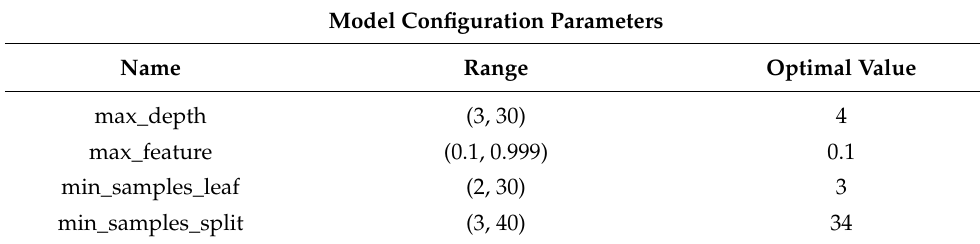
Table 2. Optimal hyperparameters and range of hyperparameters for multi-output